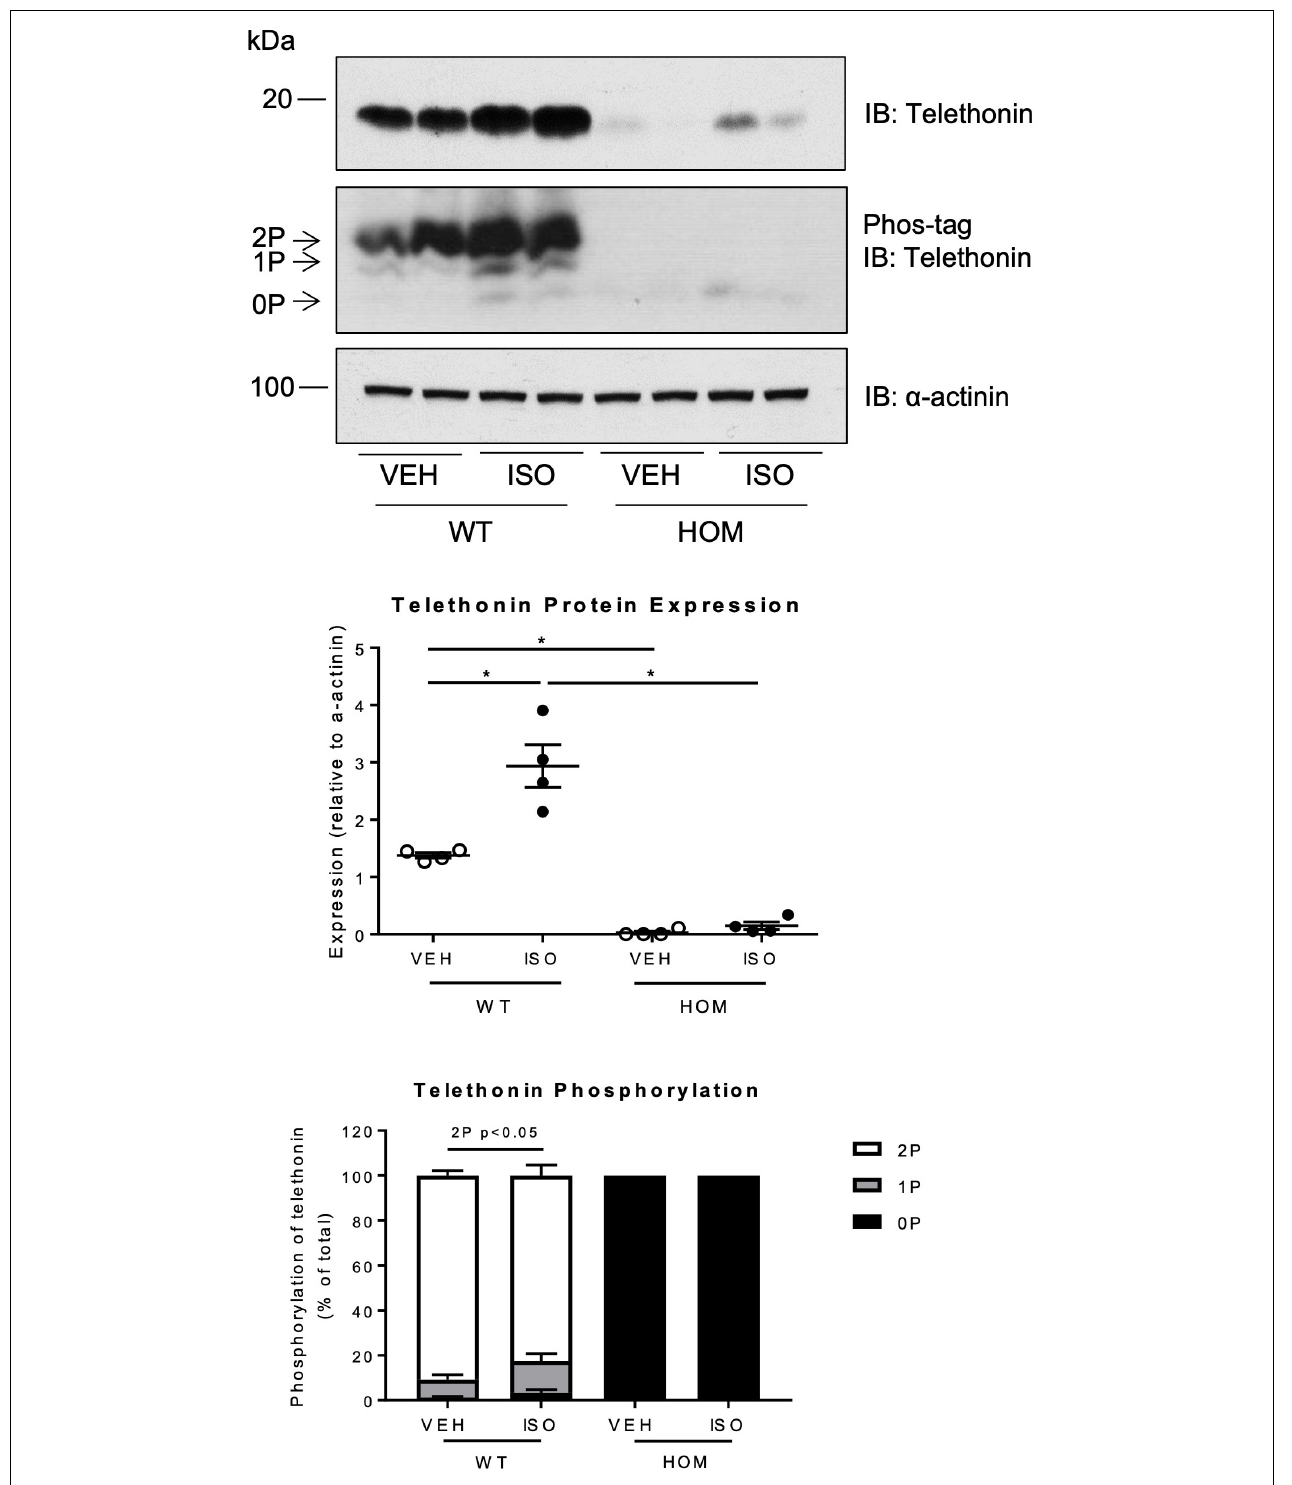
FIGURE 7 | Effects of sustained β -adrenergic stimulation on telethonin expression and phosphorylation in male Tcap S157 / 161A KI mice. Immunoblot analysis of heart homogenates subjected to SDS-PAGE or Phos-tag SDS-PAGE. 2P, 1P, and 0P indicate bis-, mono-, and non-phosphorylated telethonin moieties. Densitometric analysis of immunoblots ( n = 4) (middle panel). Densitometric analysis of telethonin phosphorylation normalized to the sum of the three phospho-moieties ( n = 4) (lower panel). Data expressed as mean ± SEM, * p ≤ 0.05; two-way ANOVA with Tukey’s post hoc test.